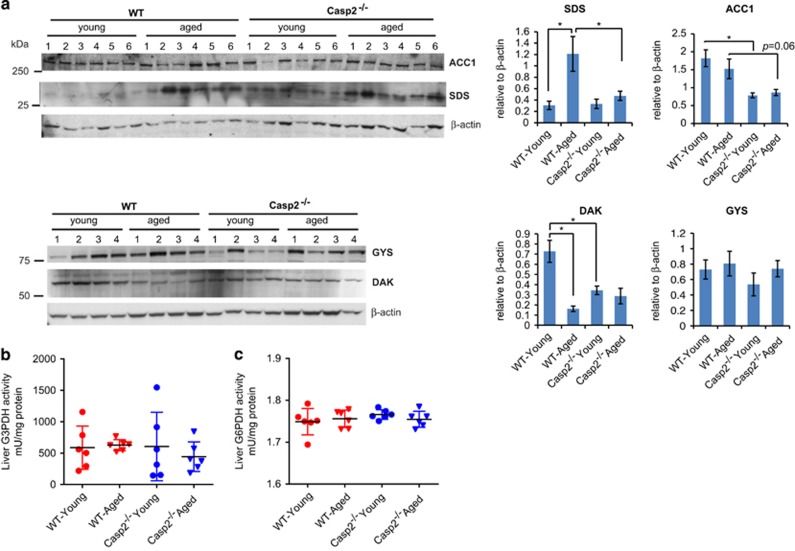
Validation of proteomics and metabolomics findings. Validation of proteomics findings in the liver lysates from young and aged WT and Casp2−/− mice. (a) Western blotting of ACC1, serine/threonine-degrading enzyme (SDS), DAK and GYS. Histograms display quantitation of the protein levels relative to β-actin loading control. (b and c) Liver enzymatic of (b) glycerol-3-phosphate dehydrogenase (G3PDH) and (c) glycerol-6-phosphate dehydrogenase (G6PDH) in liver extracts. (a) Values are means±S.E.M. (b and c) Values are means±S.D. *P<0.05; **P<0.01 (n=4–6/group)